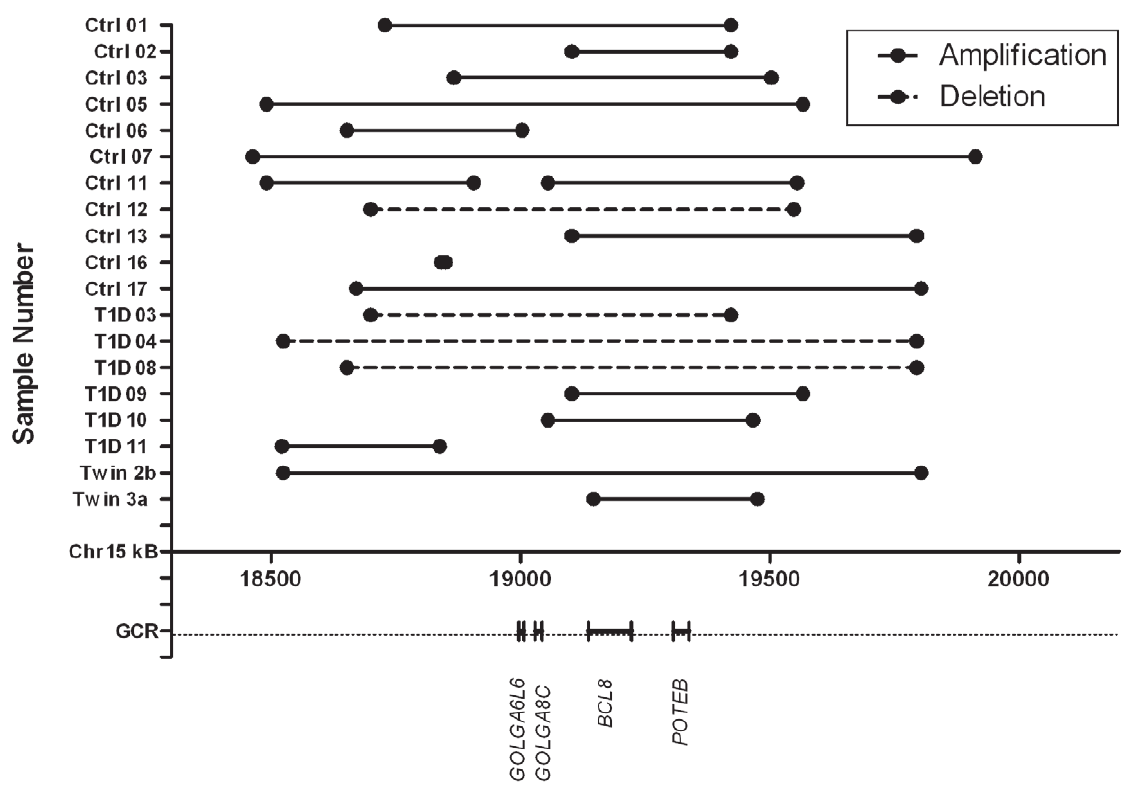
Figure 2. Individual breakpoints of CNVR A588. Starting and ending points of each variant in a 1.3 mega base pair region on chromosome 15. Below the x-axis are the gene coding regions (GCR) found in this portion of the genome.